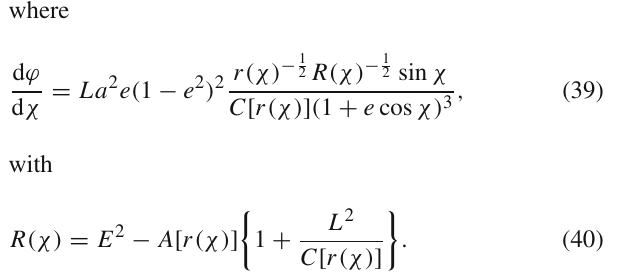
Theblack,redandbluedashedlinesrepresentthebest-fitesti- mation of, the lower and the upper limits of f SP , respectively, while the dash-dotted line indicates the line of f SP =